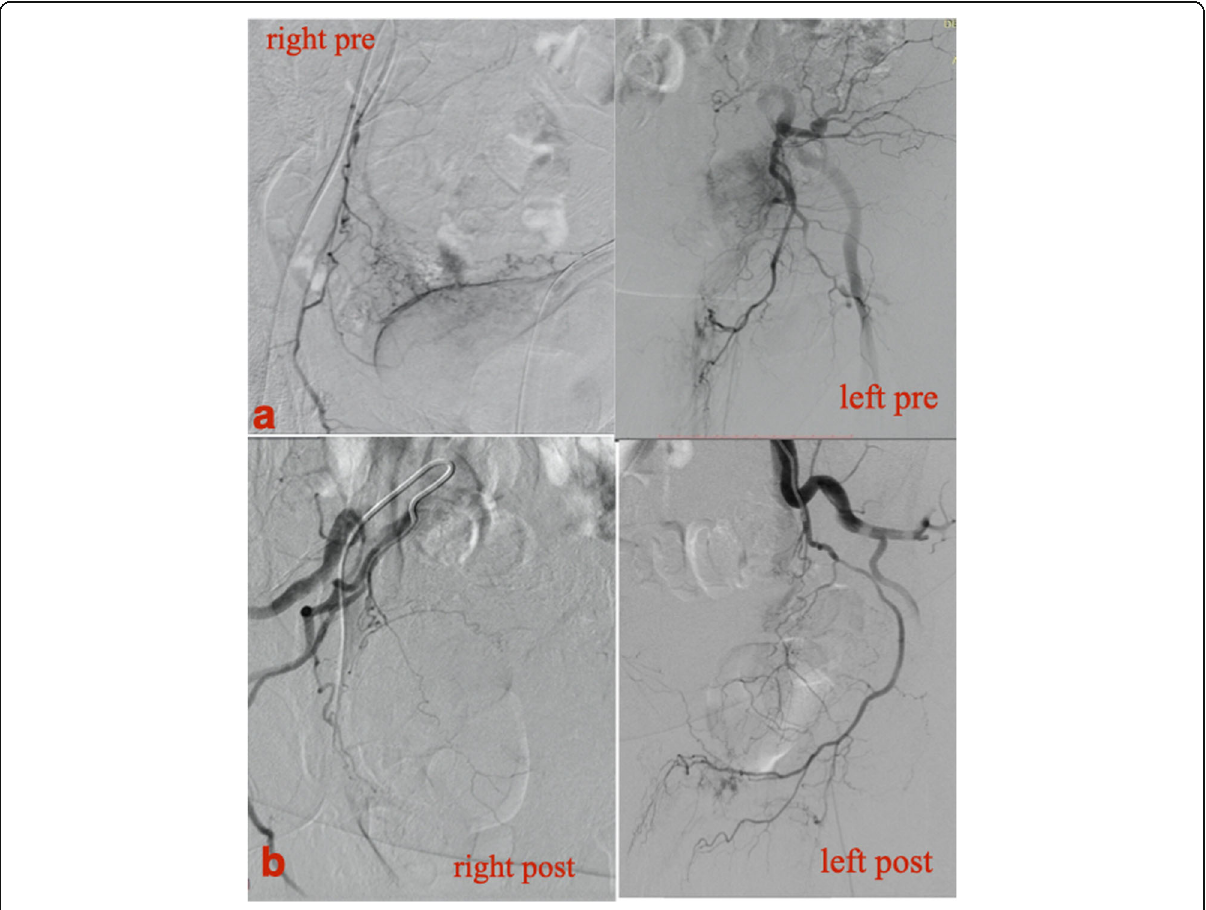
Fig. 1 Haemodynamically unstable 72-year old male patient with inoperable urinary bladder carcinoma and multiple episodes of haematuria not responding to conventional therapy. a. Selective DSA from the anterior division of the IIA bilaterally, demonstrating pathologic vascularity of the bladder. b Final DSA following micro-particle embolization (500-700 μ m) demonstrating almost complete devascularization of the bladder. Patient remained asymptomatic without clinical